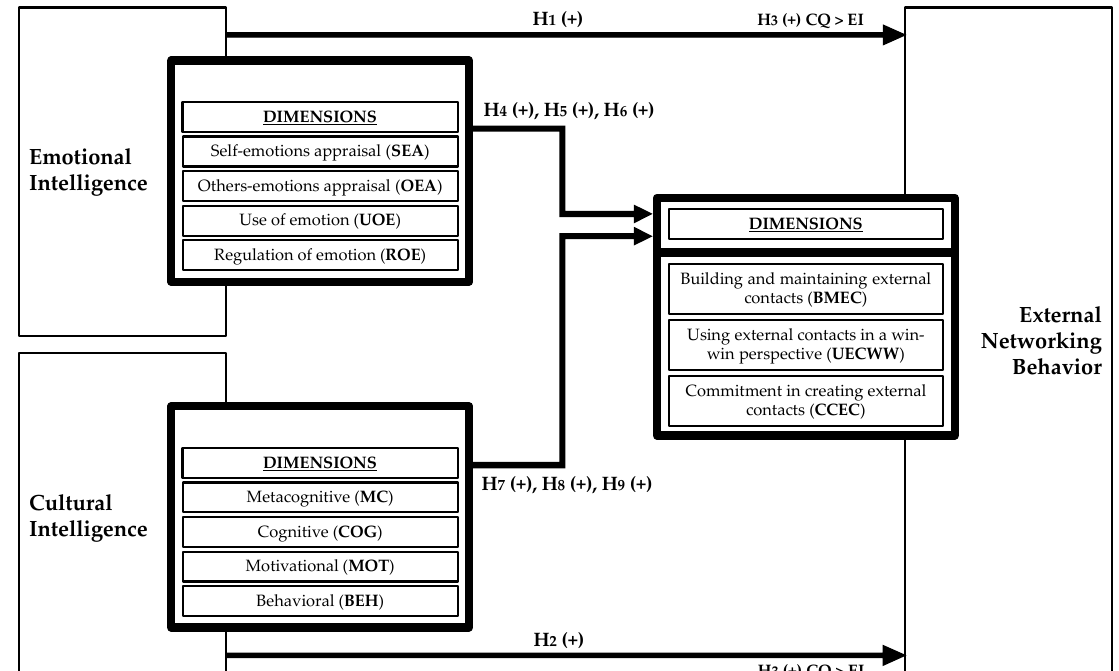
Figure 1. Research model overview.